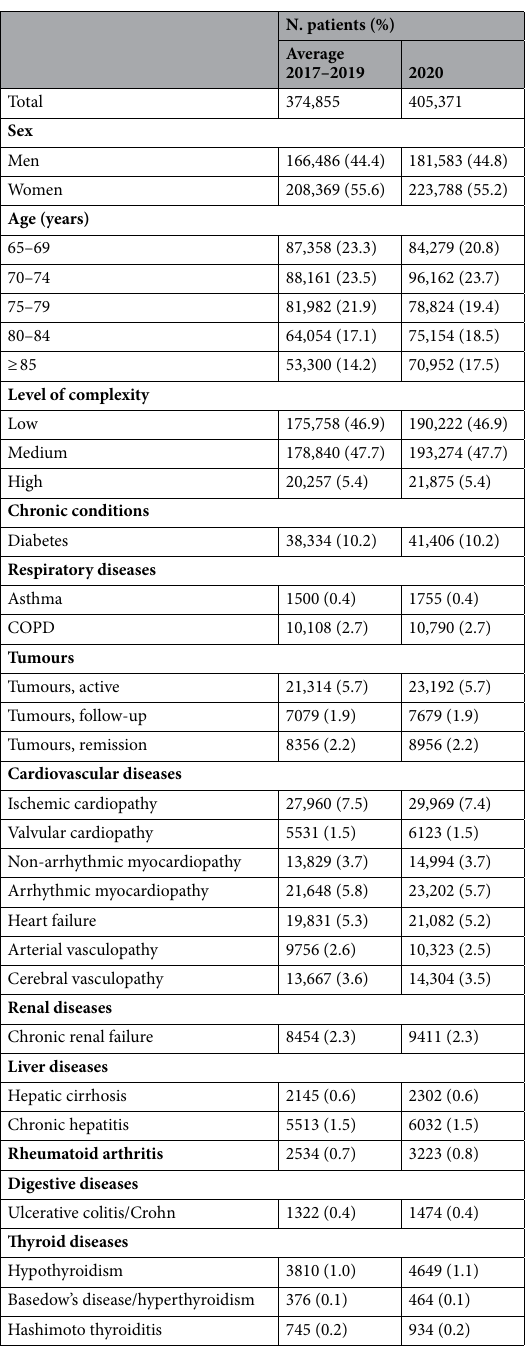
Table 1. Characteristics of individuals aged 65 years or more with a chronic disease from ATS Brianza and ATS Bergamo combined in 2017–2019 and 2020. Lombardy, Italy. COPD chronic obstructive pulmonary